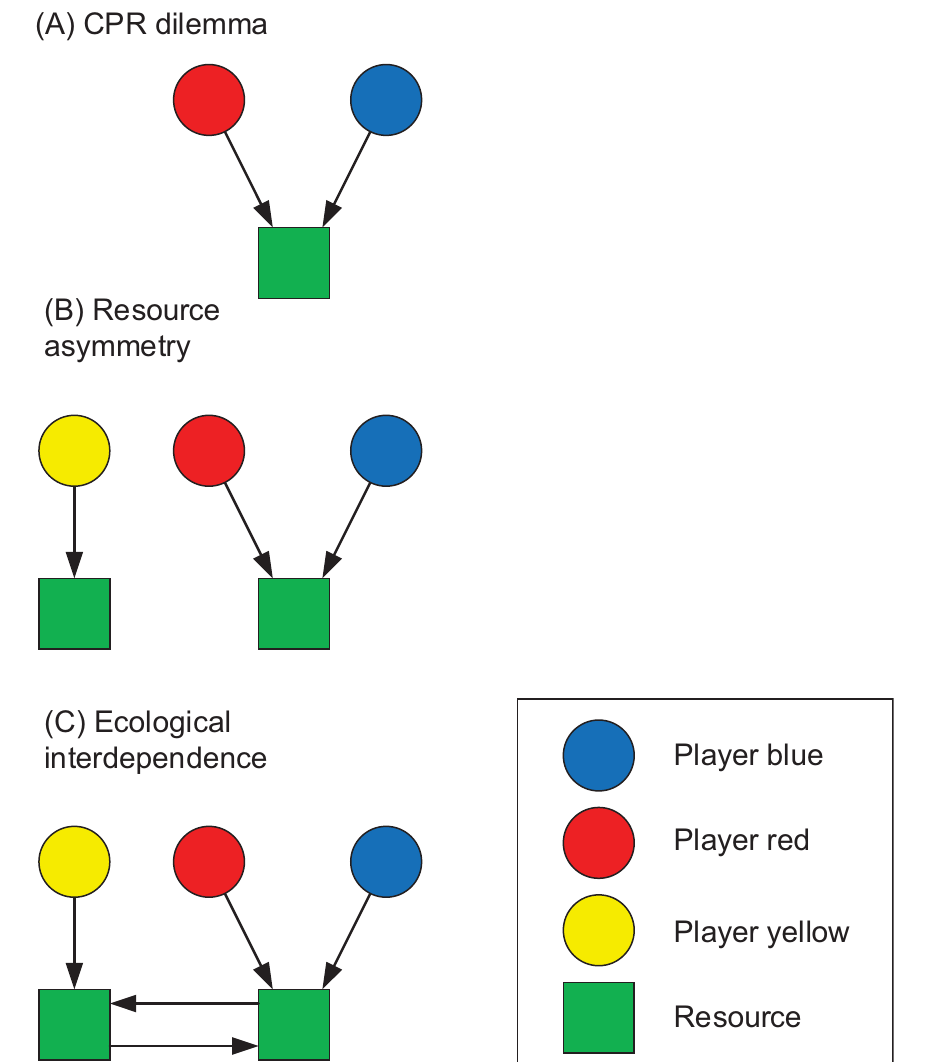
Fig 2. Graphical representation of the experimental design. A-C illustrates how common-pool resource dilemmas, asymmetries in resource access, and ecological interdependencies where added and combined to form our experimental base configuration (C). The different treatments where then applied on the base configuration by providing the players with information about others, and by giving them the ability to communicate.